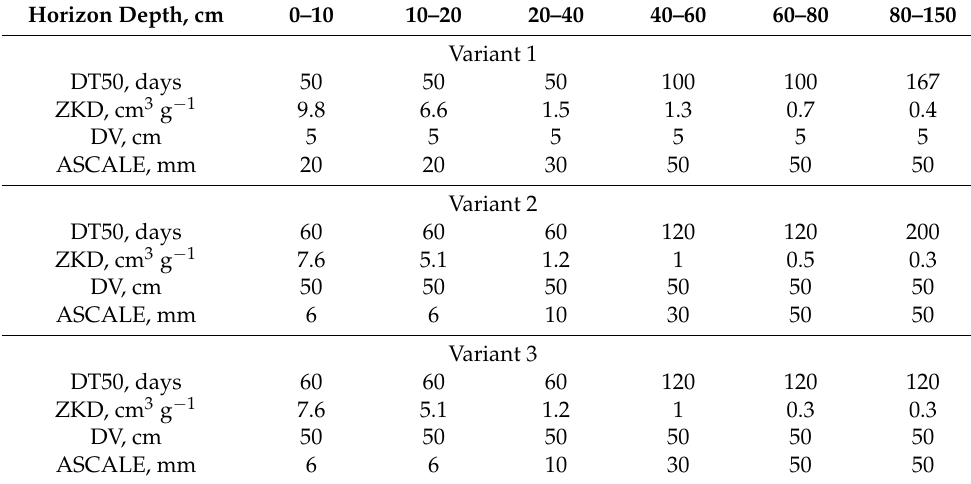
Table 8. Parameters changed during pesticide model calibration.